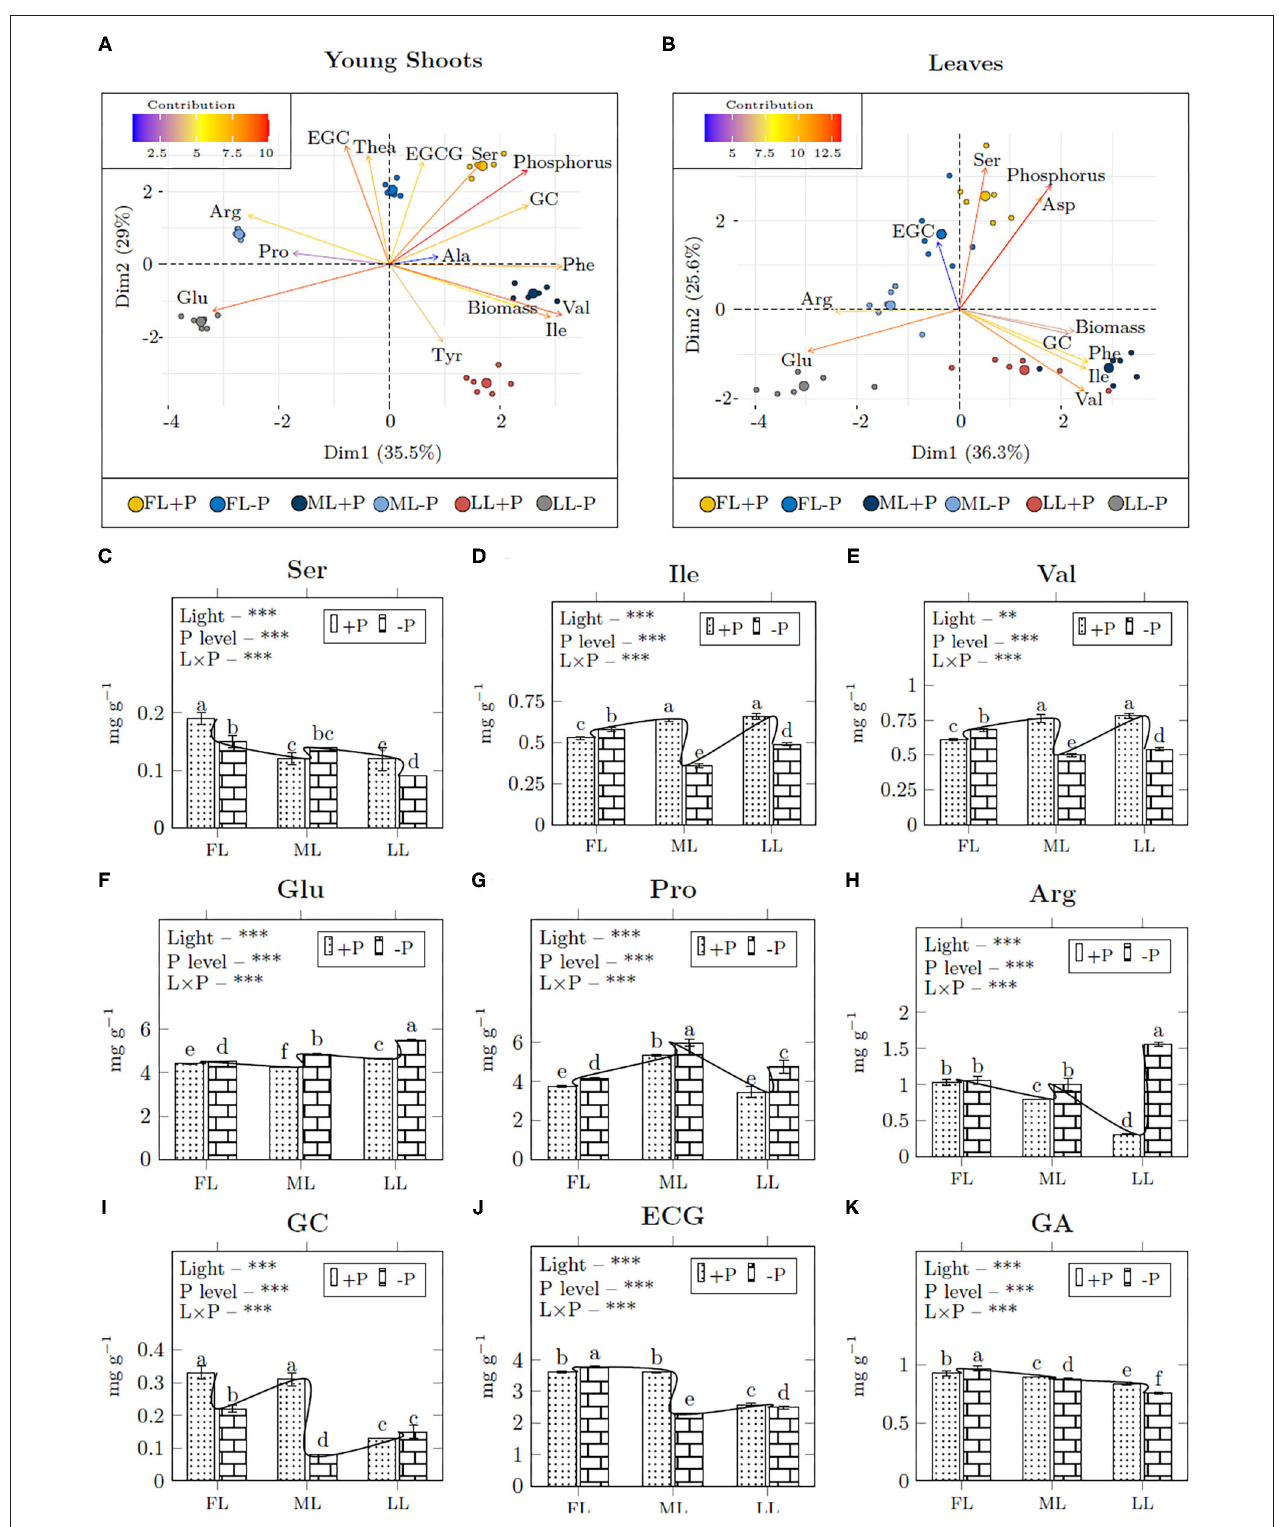
FIGURE 5 | The bi–plot correlation of young shoots (A) and leaves (B) and the mean concentration of amino acids (C–I) and catechins (J,K) in young shoots. A single bi–plot for the dataset combines both samples and treatments to the principal components; Dim1, dimension 1, and Dim2, dimension 2. Asterisks indicate significant differences: ***is 0.001, **is 0.01, and *is 0.05, ns, non-significant differences, between light and P interaction.